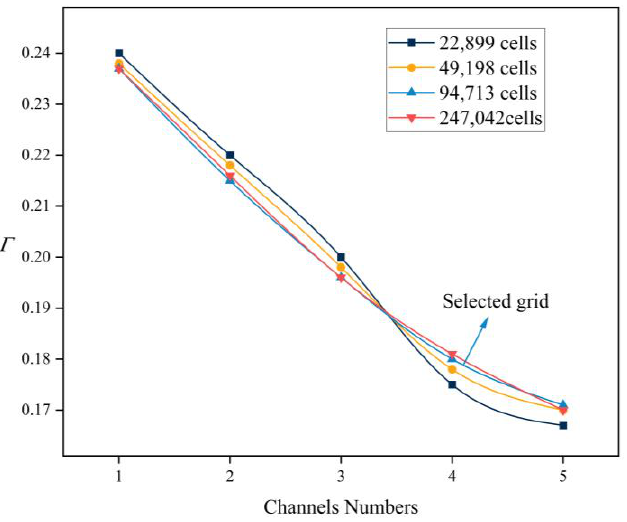
Figure 3. Grid independence verification.